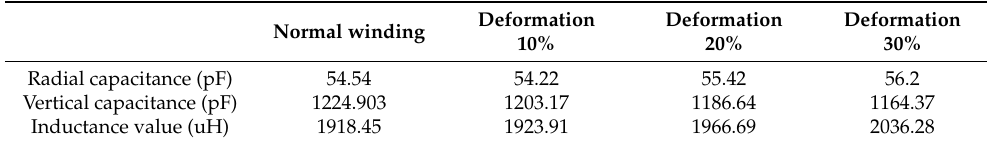
Table 8. Changes in circuit parameters.